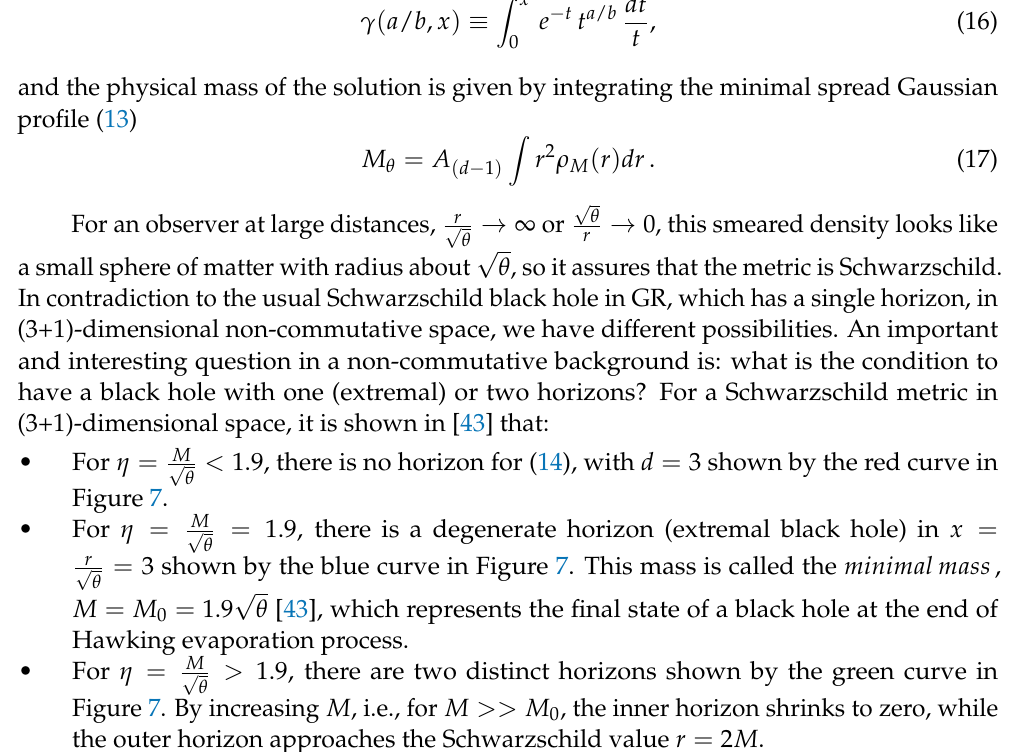
. Intercepts on the horizontal axis give radii of the θ